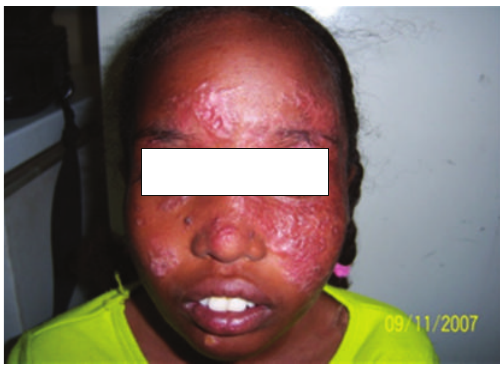
Figure 13: Of patient no. 4 showing papular rash on the